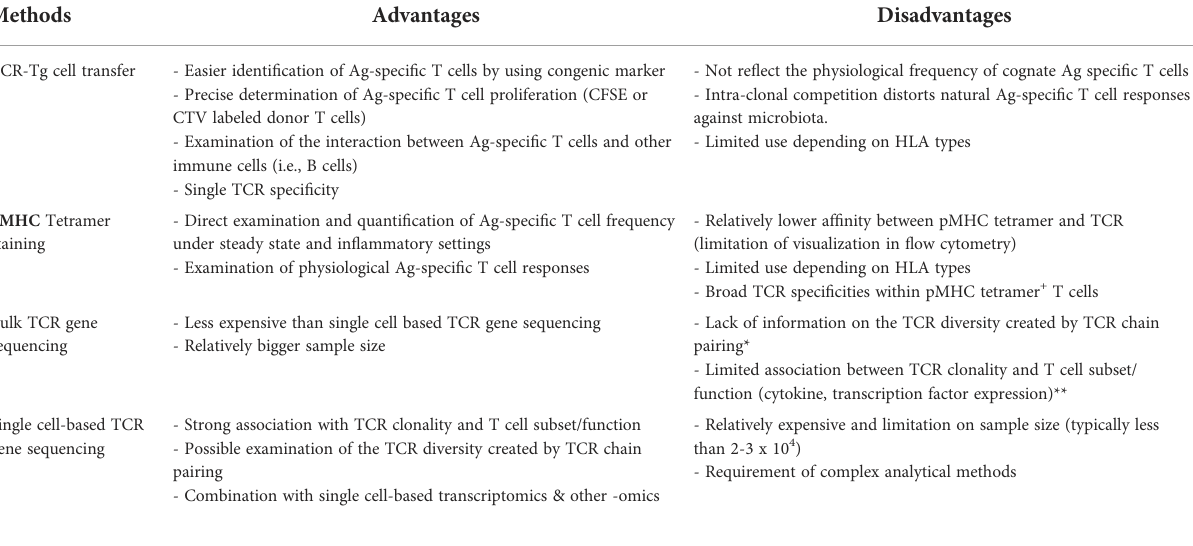
TABLE 1 Methods to examine the regulation of T cell repertoires by gut microbiota. Methods